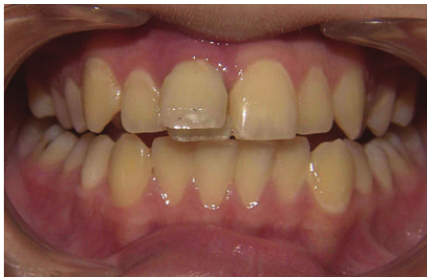
Figure 1: Clinical aspect of the crow fracture to the maxillary right central incisor.